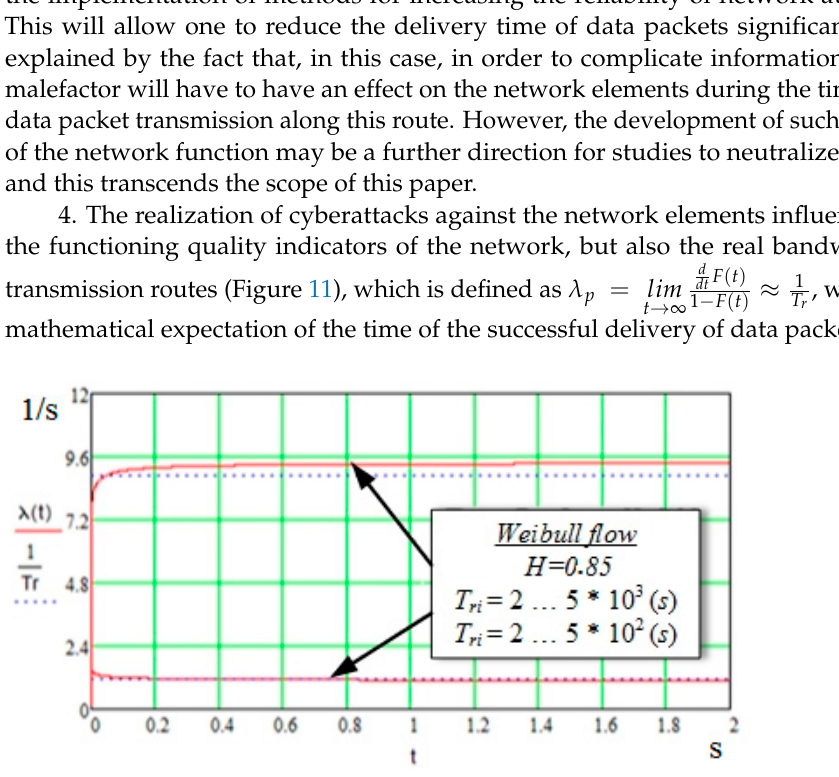
Figure 11. Dependence graph of flow intensity of successfully transmitted data packets when time values of the realization of cyberattacks are different.